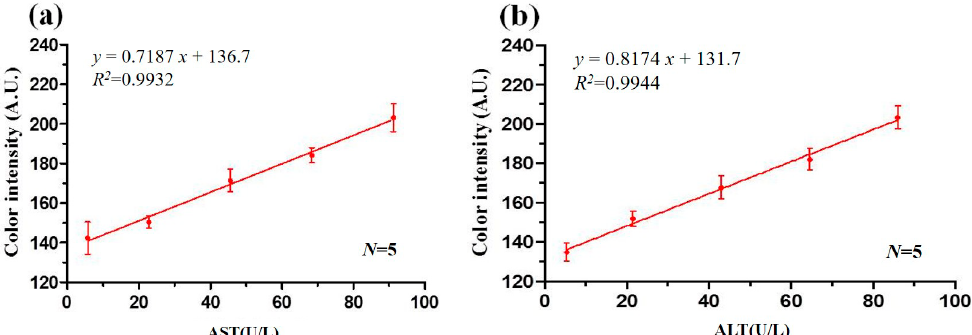
Figure 7. ( a ) AST calibration curve; ( b ) ALT calibration curve.